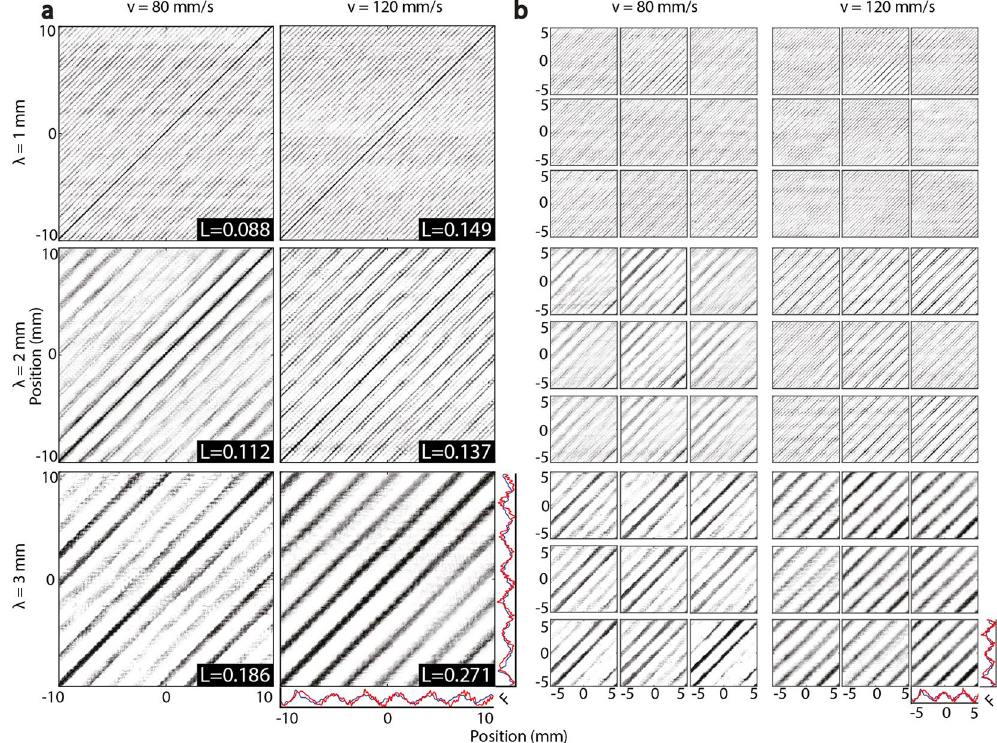
Figure 3. Mean JRPs of ( a ) all 880 combinations as well as ( b ) subject-specific measured and simulated trial pairs. The spacing of diagonal structures reflects the fundamental period of forces, and resembles that of the surfaces. While minor differences in the force patterns of the participants exist, the friction dynamics characteristics in each condition are preserved. The quantification analysis yielded mean recurrence lengths L indicating greater agreement between simulations and measurements at higher speeds and longer wavelengths.